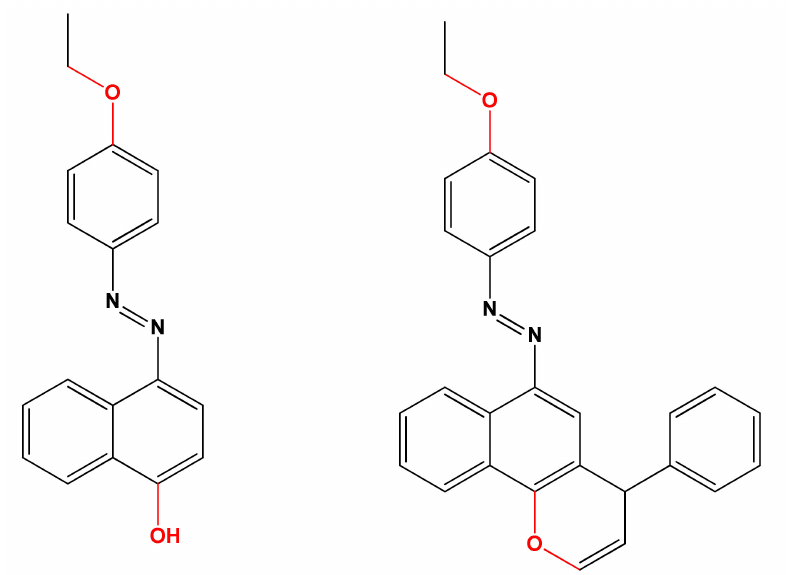
Figure 9. Structures of Fat Brown B and 1-(4-ethoxyphenyl)-2-(4-phenyl-4H-benzo[ h ]chromen-6- yl)diazene [55].